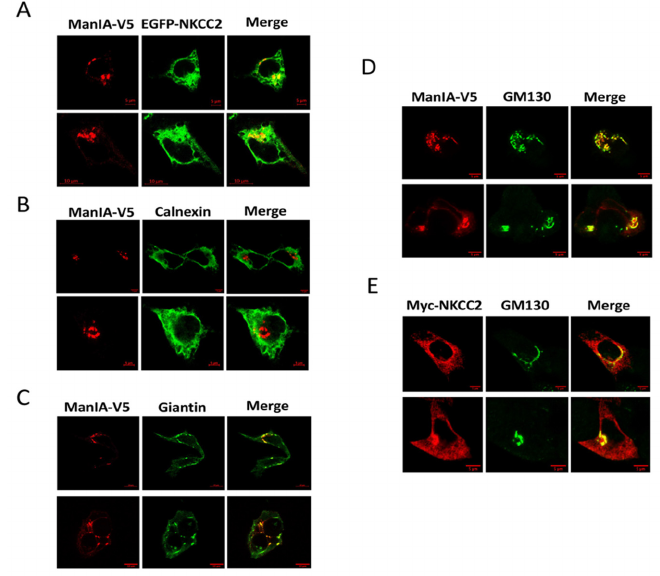
Figure 2. ManIA co-localizes with NKCC2 mainly at the cis-Golgi network. ( A ) imunofluorescence confocal microscopy showing distribution of EGFP-NKCC2 (green) and ManIA-V5 (red) in HEK cells. Fixed and permeabilized cells were stained with mouse anti-V5 for ManIA (Texas Red). The yellow color (merged image) indicates colocalization of the proteins. ( B − D ) comparison between the cellular localization of ManIA and ER or Golgi markers. Cells transfected with NKCC2 tagged with Myc and ManIA tagged with V5 were fixed after transfection, immunostained with anti -calnexin (ER marker) or Giantin (cis- and median Golgi marker) or GM130 (cis-Golgi marker) antibodies and visualized with texas-red of ManIA (red) and FITC conjugated secondary antibodies for each organelle marker. Analysis was performed by confocal laser scanning microscopy. ( E) comparison between immmunostaining of Myc-NKCC2 with that of the cis-Golgi marker GM130. The yellow color (merged image) indicates colocalization of the proteins. Bars, 5 or 10 μ m.